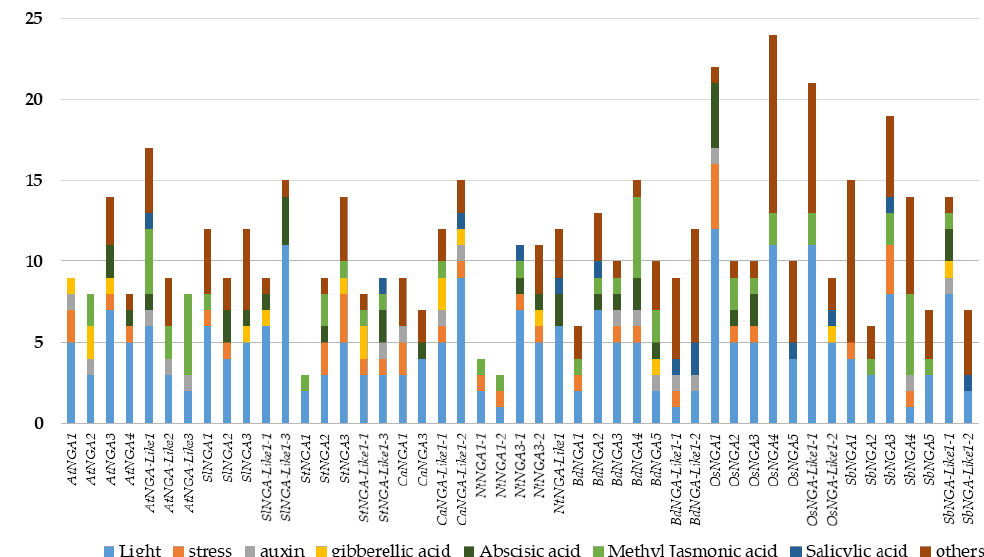
Figure 3. The analysis of cis -acting elements in the promoters of NGATHA genes. The X-axis represents the NGATHA genes, and the Y-axis represents the number of cis -elements in the promoter of each gene. The cis -elements were predicted in the 1500 bp upstream regions using PlantCARE (http://bioinformatics.psb.ugent.be/webtools/plantcare/html/; accessed on 30 January 2022) [30]. “Others” include promoter elements related to anaerobic induction, circadian control, meristem development, flavonoid biosynthesis, zein metabolism, seed specific regulation, endosperm expression and cell cycle regulation.